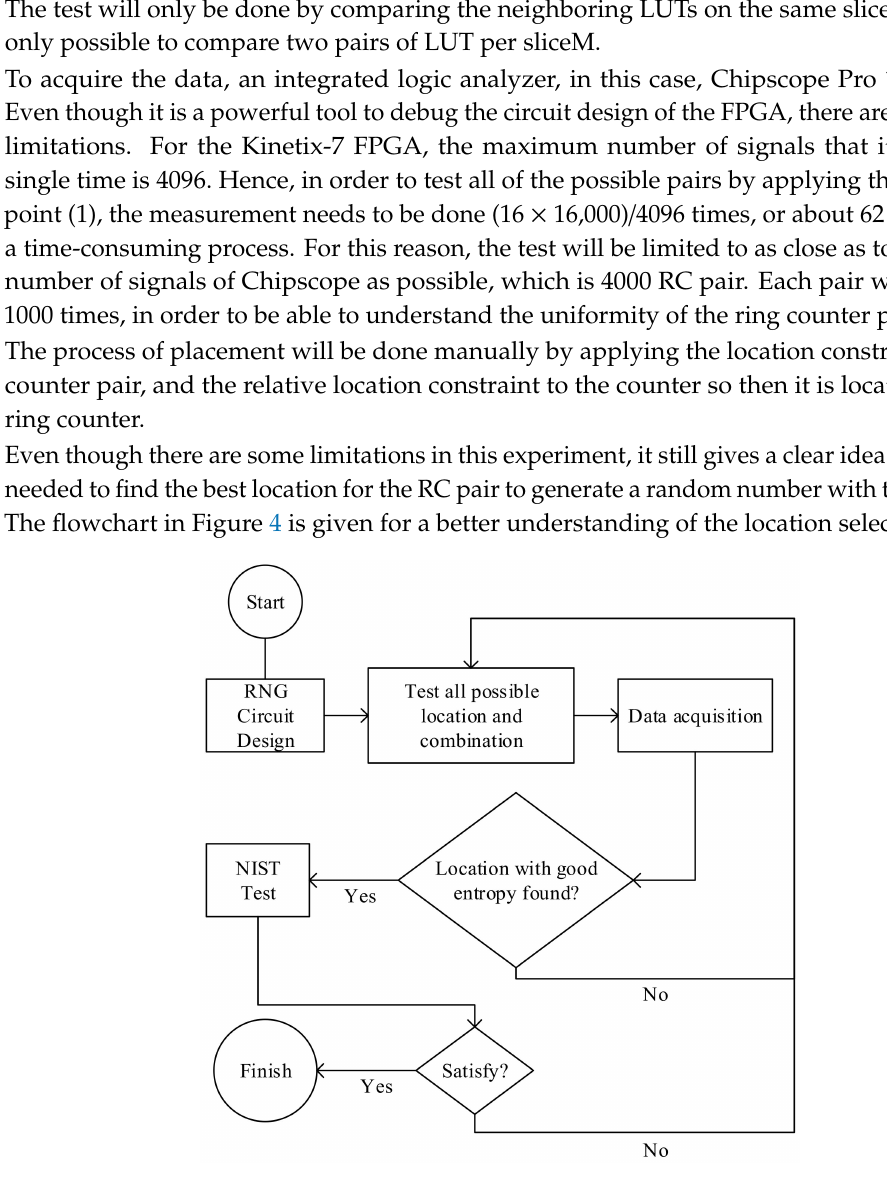
Figure 4. Location selection